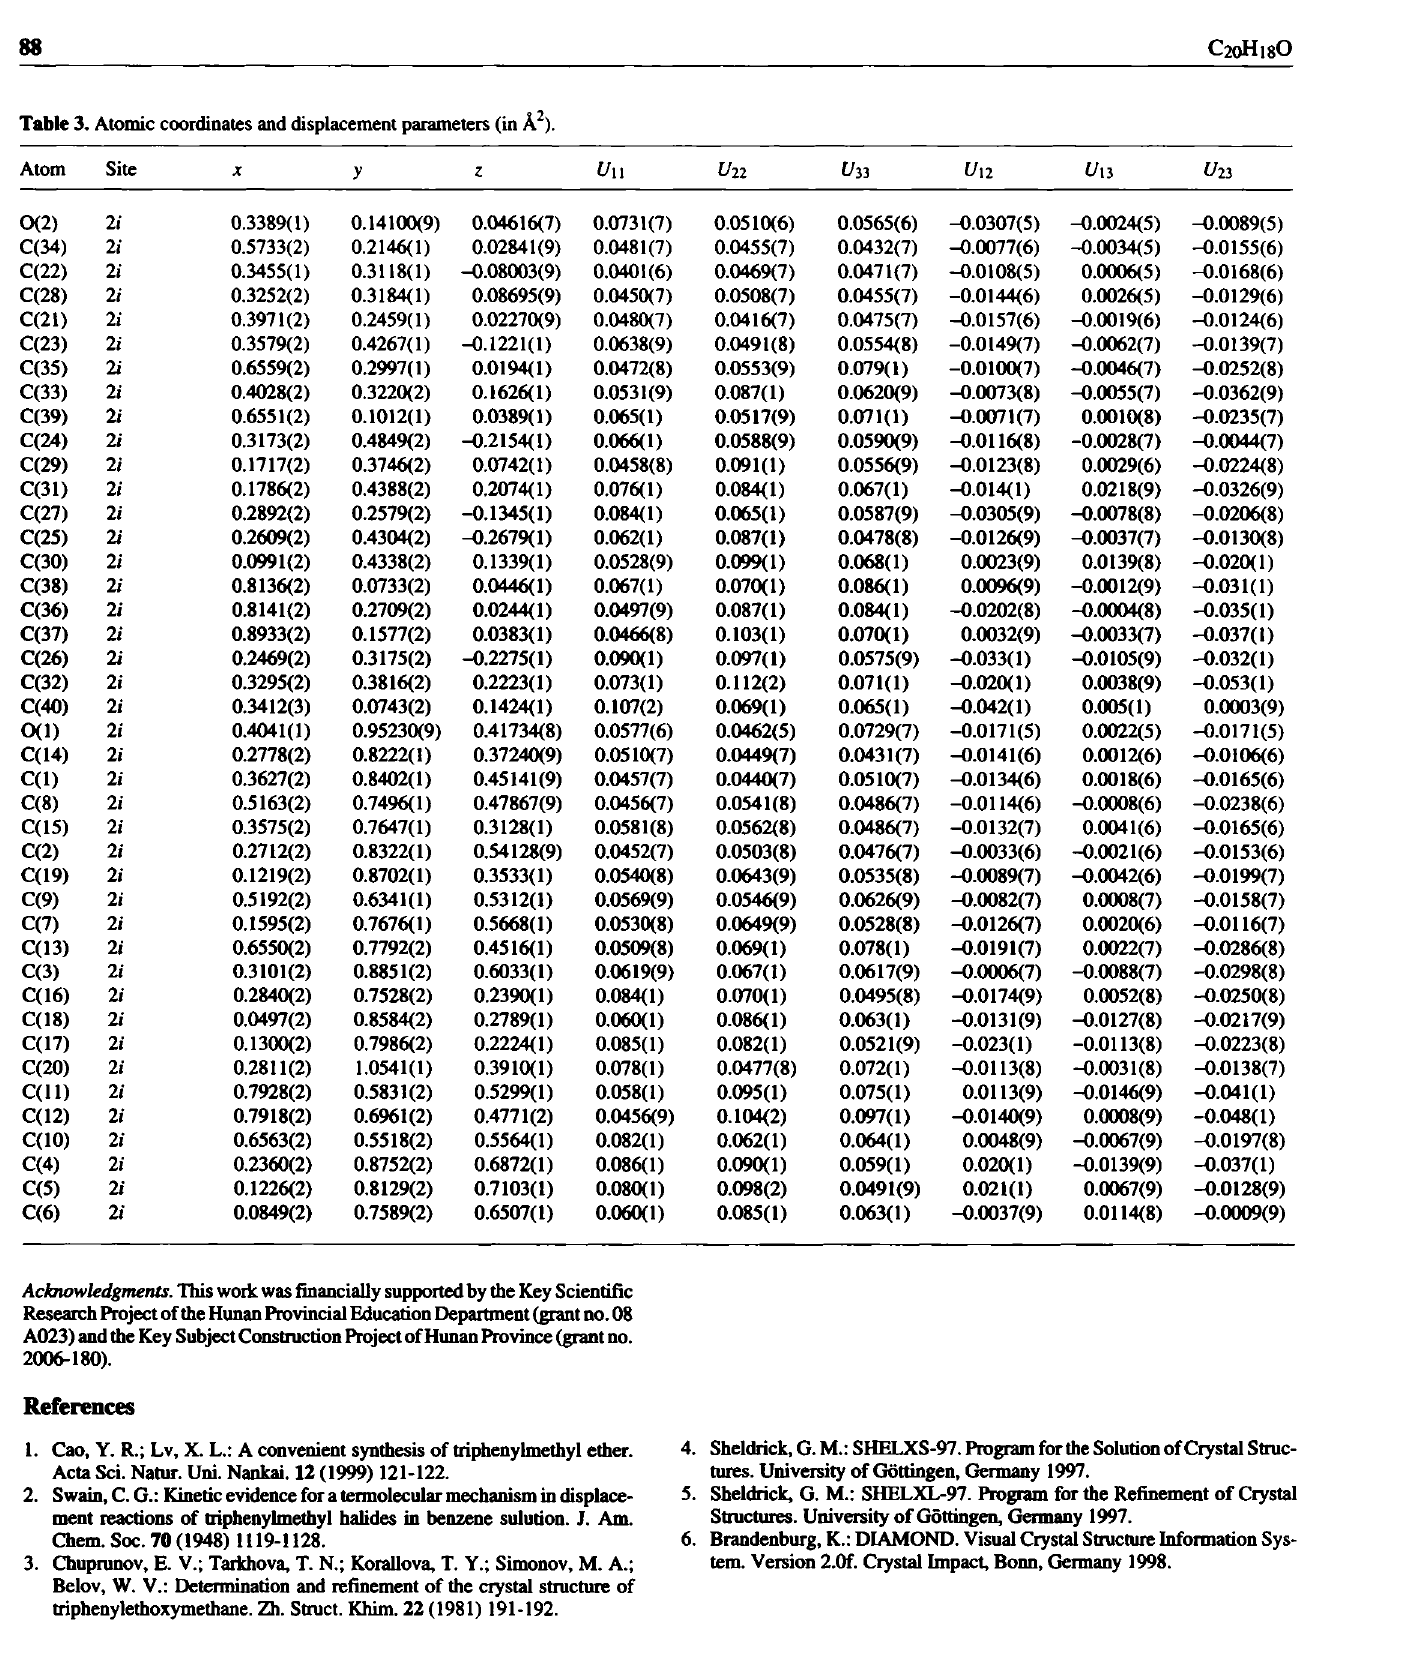
Table 3. Atomic coordinates and displacement parameters (in Â 2